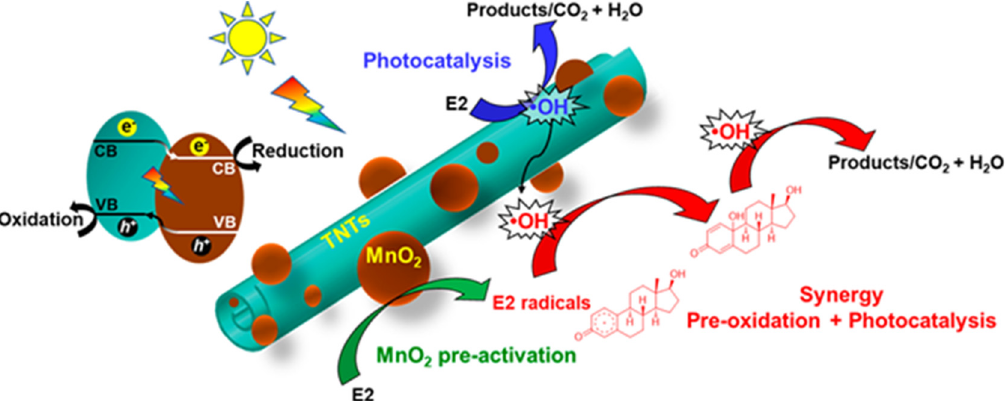
Figure 13. The schematic mechanism of the degradation of E2 by using MnO 2 NPs decorated titanate nanotubes (TNTs). Reprinted with permission from [161], Copyright (2018) American Chemical Society (ACS).